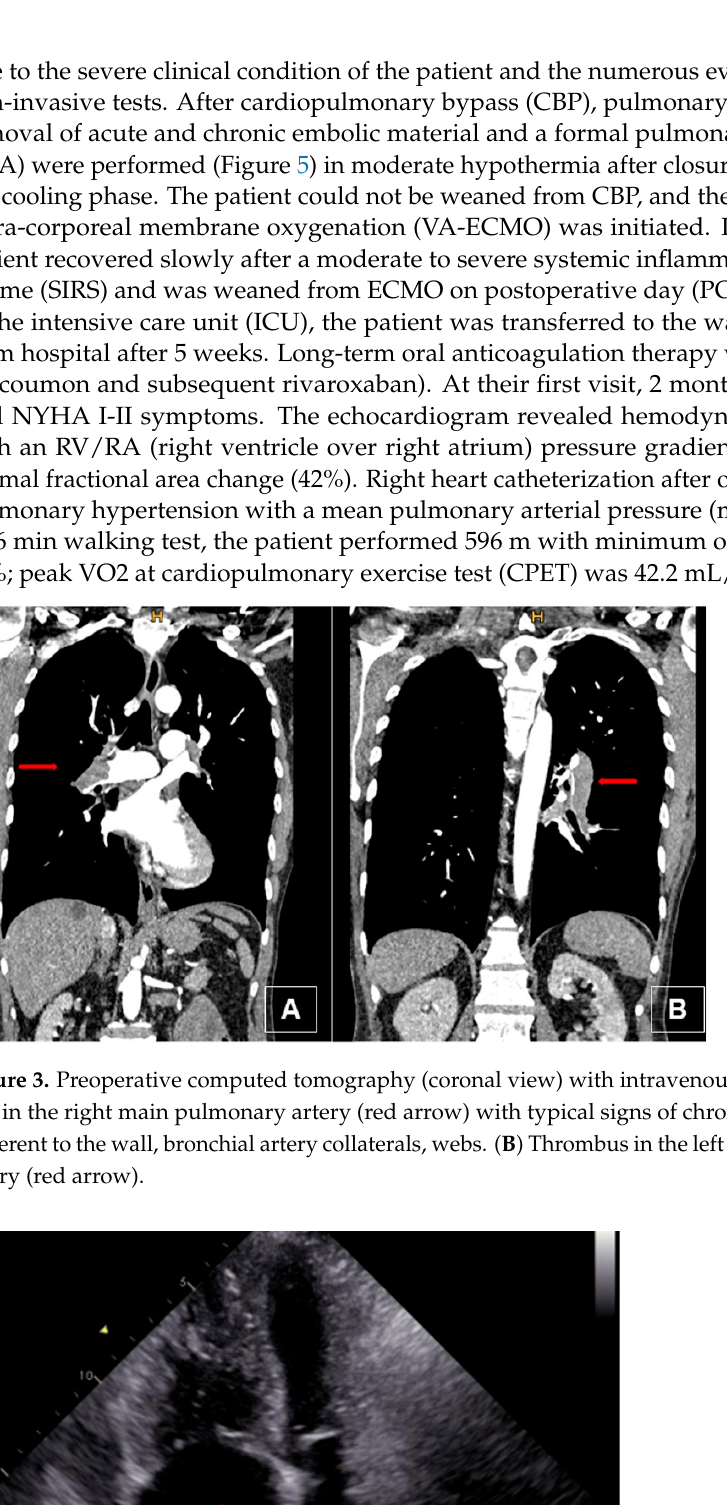
Figure 5. Right and left sided thrombendartherectomy specimen. Right : Rudimentary upper lobe specimen and lower lobe branches are depicted, and fresh emboli chronic material is clearly visible (red arrows). Left : Superior segment and basal lower lobe segment specimen. 2.2. Case 2 A 48-year-old man was admitted to the emergency department of another hospital for dyspnea and syncope. CT scan and echocardiography showed massive central, bilat- eral pulmonary emboli (Figure 6); severe RV dysfunction (Figure 7); and signs of CTEPH. He had an acute episode dyspnea, which was spontaneously resolved after a long flight a few months earlier. An in-hospital second event led to respiratory and heart failure de- spite prompt thrombolytic therapy. Because of ongoing shock, a VA-ECMO was initiated. Due to the necessity of reinsertion of the ECMO after initial successful weaning, the pa- tient was referred to our hospital for surgical evaluation. On VA-ECMO, blood flow of 4.8 L/min, he had a mean mPAP of 34 mmHg. Medical therapy with sildenafil and ilomedin- inhalation did not lead to an improvement. Therefore, surgical treatment was discussed